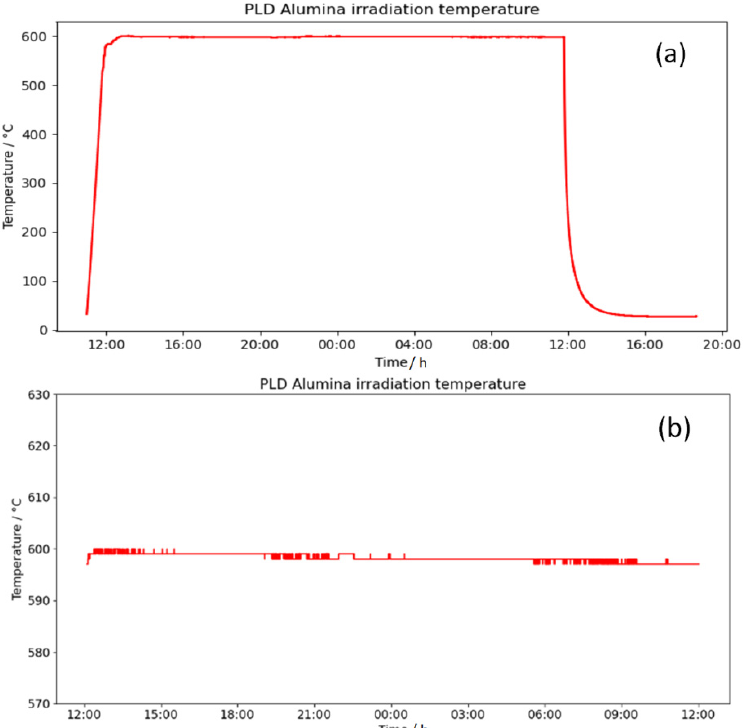
Figure 12. ( a ) Sample temperature is kept constant even in prolonged irradiation lasting over 24 h, shown here for irradiation of 24 h irradiation of Al 2 O 3 -coated steel sample by 12 MeV Au +5 ions of constant flux equal to 10 11 ions/cm 2 . ( b ) Zoom-in of temperatures in the range of 550–650 ◦ C, showing temperature variation of ± 1 ◦ C.